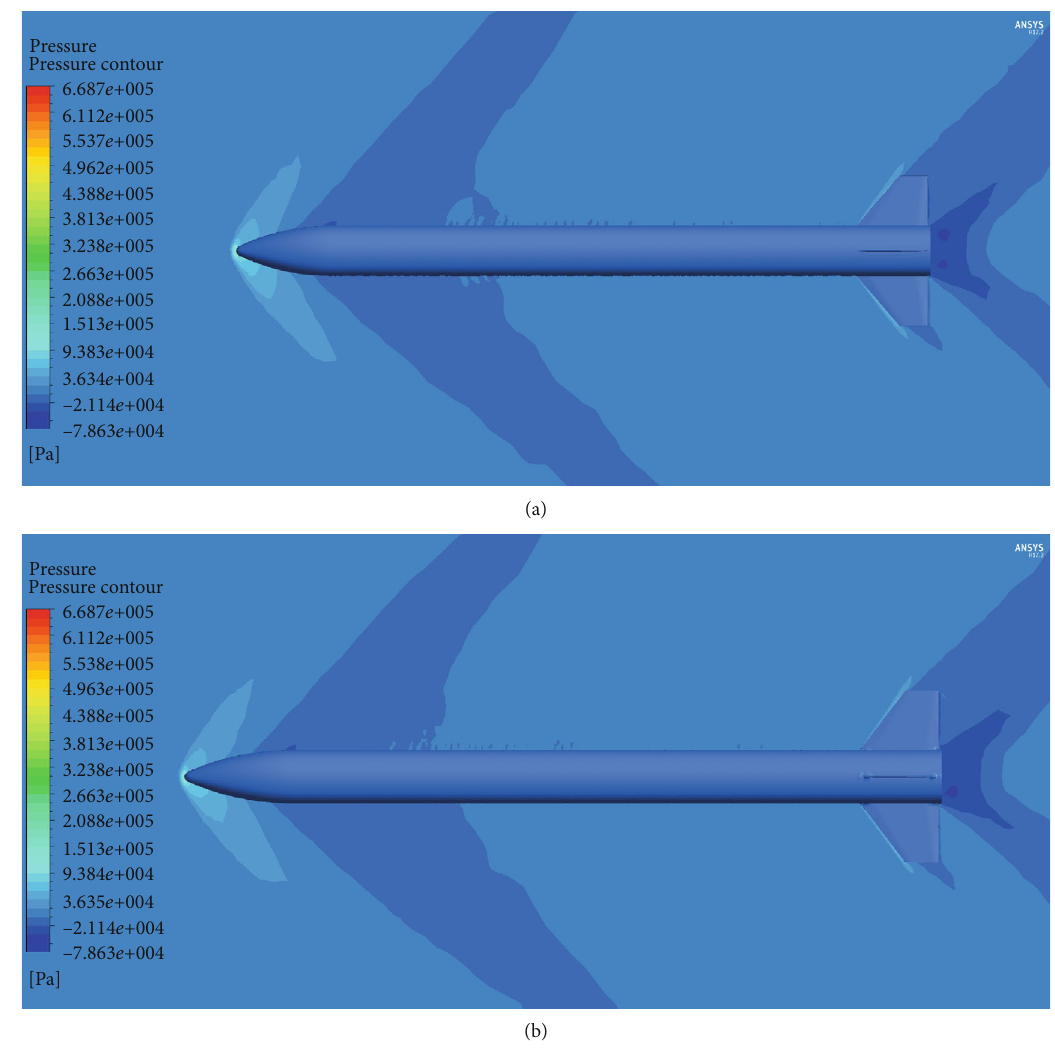
Figure 13: Comparison of the pressure contours of the optimum and baseline missile models at 1.4 Mach number and 4 ° AoA: (a) baseline model and (b) optimum